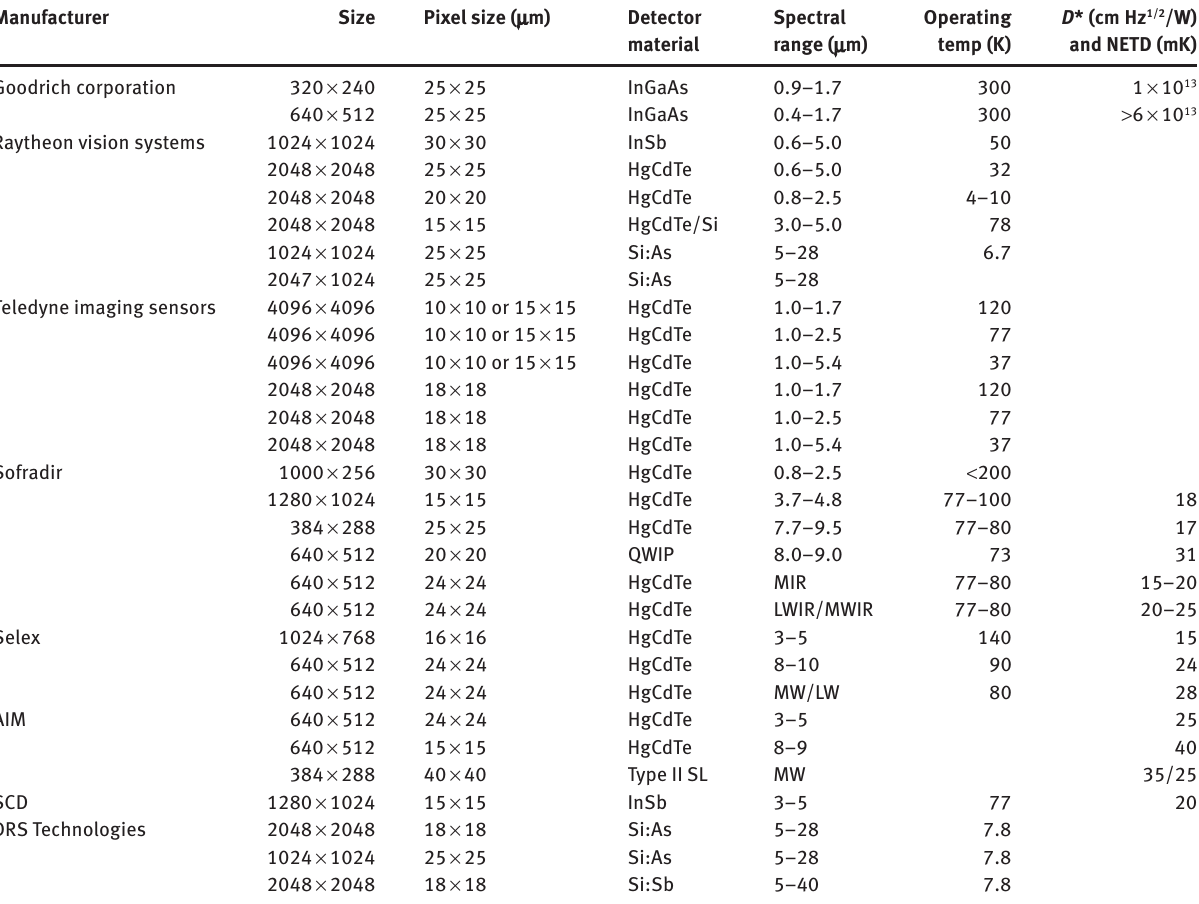
Table 1: IR FPA by established manufacturers